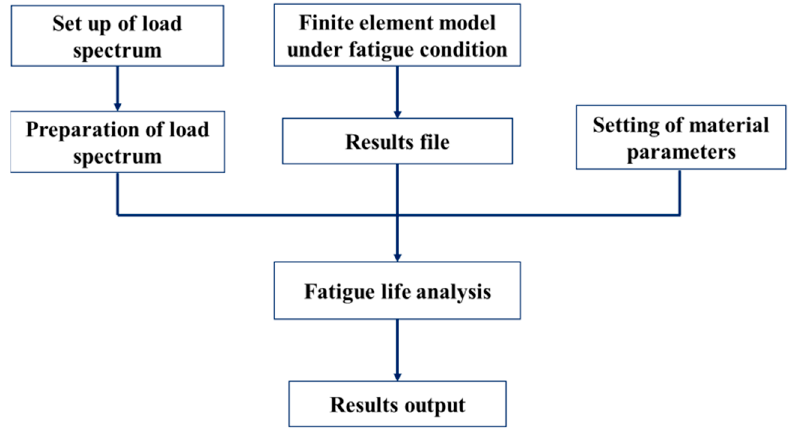
Figure 14. Analysis flow